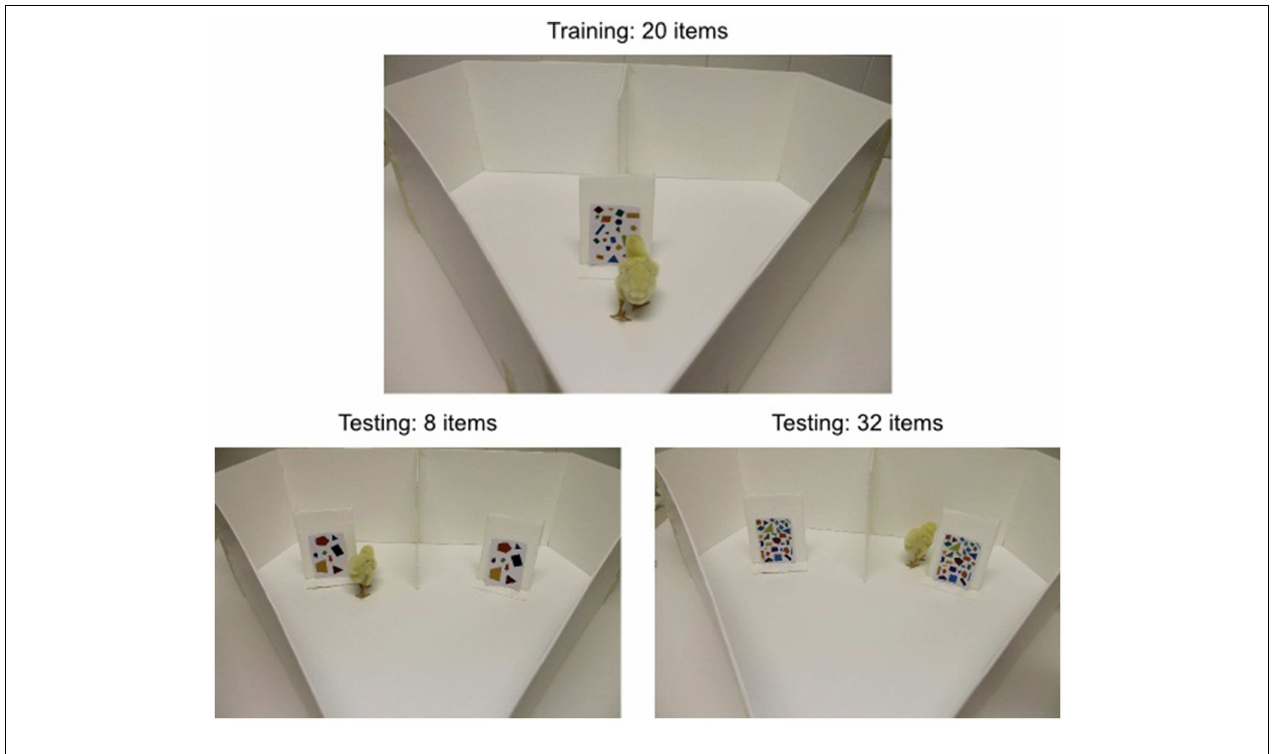
test (8 vs. 8) shown at left and the high-number test (32 vs. 32) shown at right. The images depict a control condition where shape, size, and color of the items were varied. Photographs courtesy of Rosa